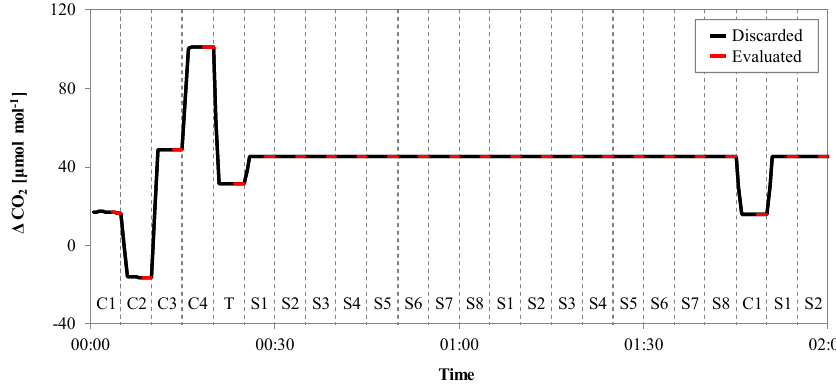
Figure 3. Example of a calibration sequence from a low-flow measurement. The x axis represents time and the y axis the delta signal of the NDIR analyzer. The gas measured is indicated by the codes at the bottom of the figure (“C” is calibration gas, “T” is target gas and “S” is sample gas), and the switching of the valve is marked by the dashed vertical lines. Each gas was measured for 5min, to avoid mixing and memory effects; the first 3min were discarded (black lines) and only the last 2min (red lines) were used for further